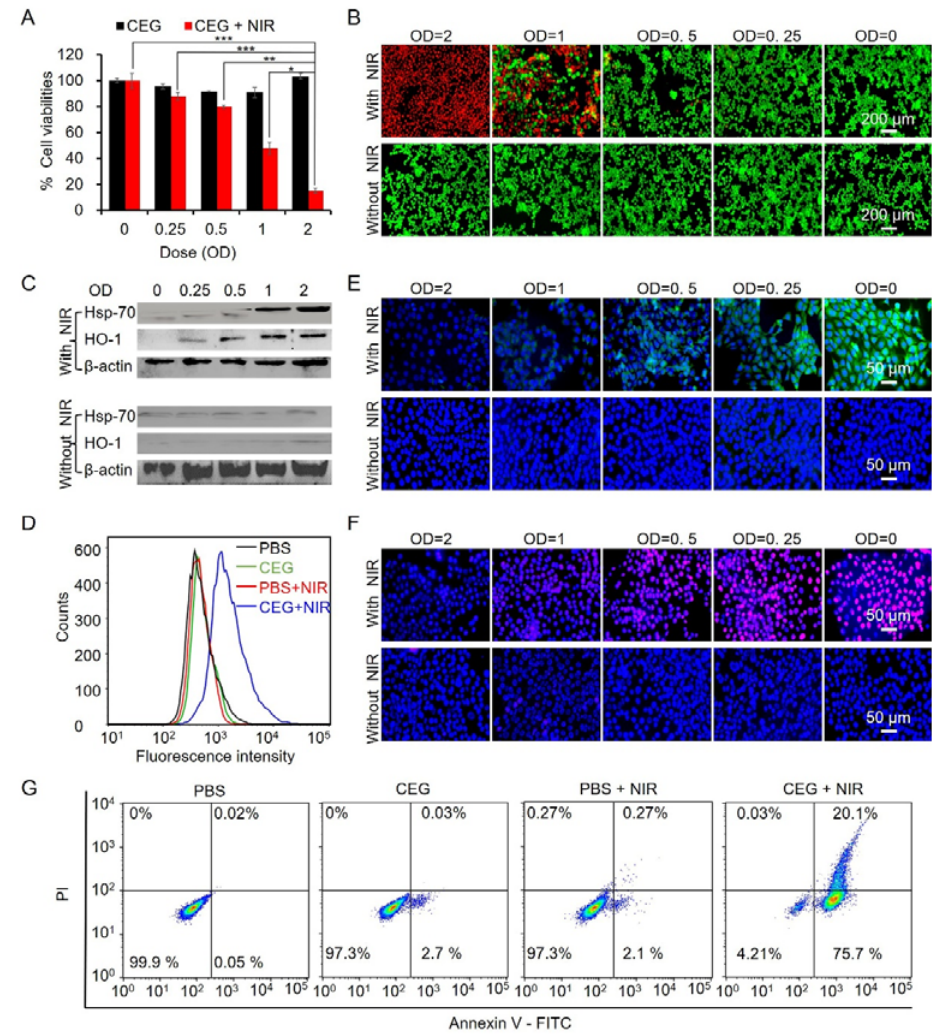
Figure 4. In vitro phototherapeutic efficacy of CEG in 4T1 cells. ( A ) Result of CCK-8 assay showing the cell viability of 4T1 cells following the treatment of CEG (OD = 0, 0.25, 0.5, 1, and 2) without or with 808 nm laser irradiation (1 W/cm 2 , 10 min). ( B ) Live/dead staining of 4T1 cells treated with CEG (OD = 0, 0.25, 0.5, 1, and 2) without or with 808 nm laser irradiation (1 W/cm 2 , 10 min). ( C ) Results of western blo tt ing showing the expression levels of HSP-70 and HO-1 without or with NIR laser irradiation. ( D ) Flow cytometric analysis of intracellular ROS levels in 4T1 cells after the treatment of CEG upon 808 nm laser irradiation or not. CLSM images of ( E ) mitochondrial membrane depolarization (JC-1, green) and ( F ) superoxide production (Mitosox Red, red). DAPI staining for Cell nuclei (blue). ( G ) Analysis of fl ow cytometry for the apoptotic 4T1 cells induced by CEG upon 808 nm laser irradiation or not. Statistical di ff erences were determined by Student’s t-test. * p < 0.05, ** p < 0.01, *** p < 0.001.